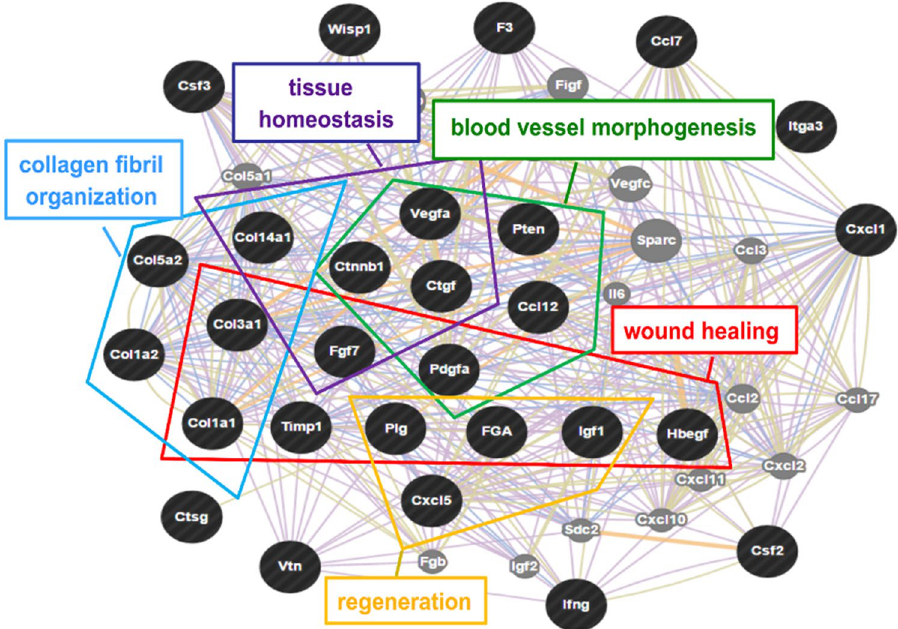
Figure 7. Differential genetic profile induced by CSCL at 21 days. Functional classification of over-expressed genes in CSCL in vivo implants from wound healing PCR array by using GENEMANIA web analysis tool.